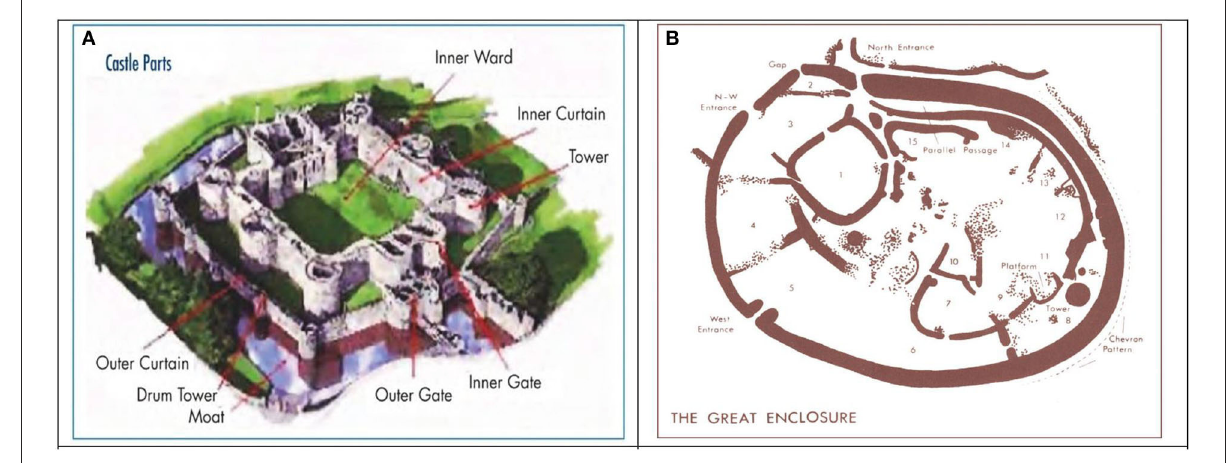
FIGURE2 Crime, safety, and security plus site, urban design, and spatial planning examples from the history of town planning. (A) Fema’s site and urban design for security historic European settlement spatial structure. (B) Great Zimbabwe site and urban design African settlement spatial structure. Source: Fema (2007) and Chirikure and Pikirayi